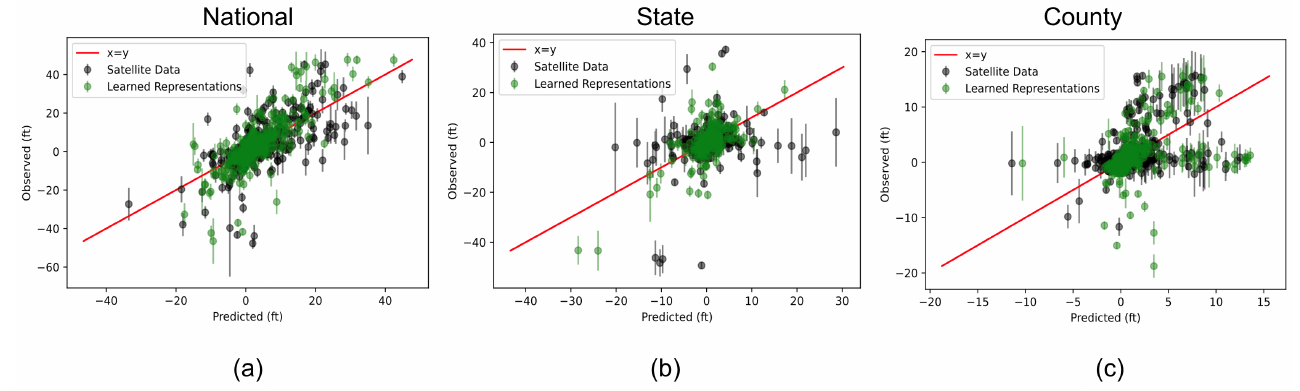
Figure 10. Scatterplots of satellite data and learned representations models performance with error bars: ( a ) national model, ( b ) state model, ( c ) county model. Random sample of 500 points for better